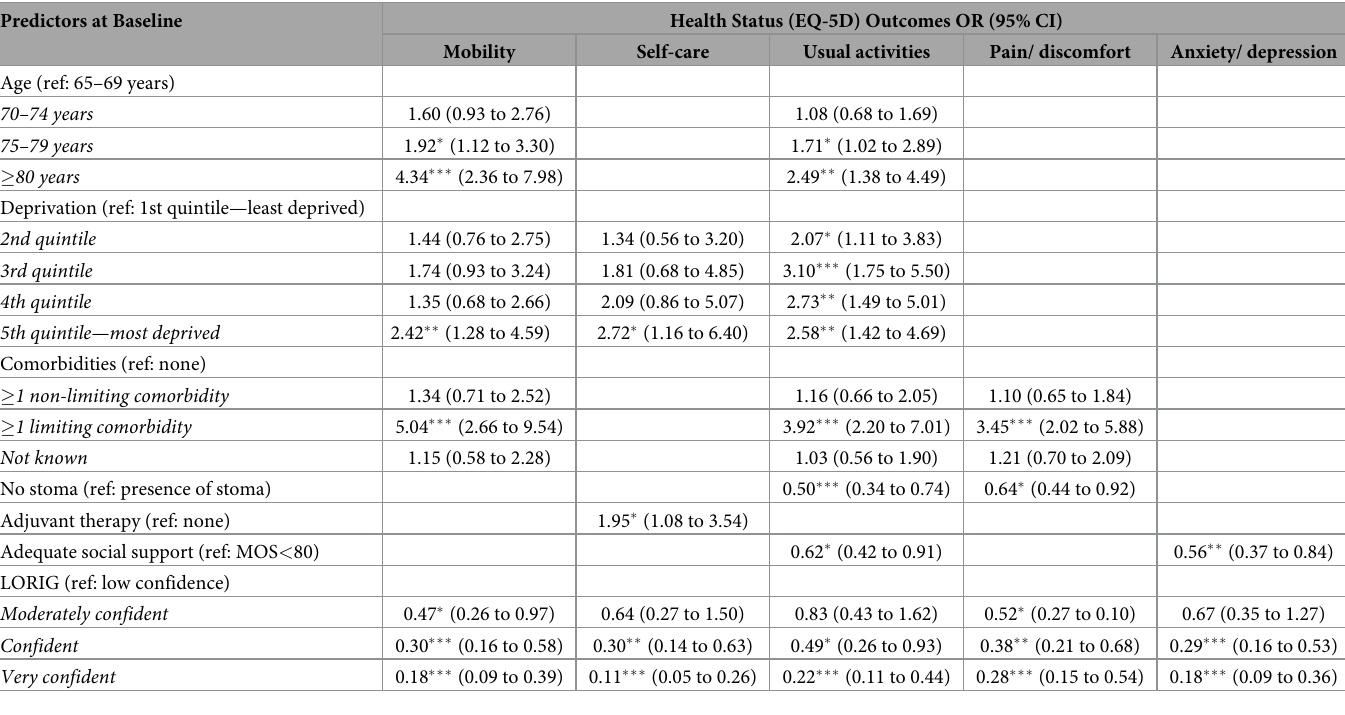
Table 3. Logistic regression models predicting health problems separately in five EQ-5D domains over the five-year follow-up post-surgery, predictors collected at baseline (pre-surgery), presented coefficients converted to odds ratios (ORs) and 95% confidence intervals